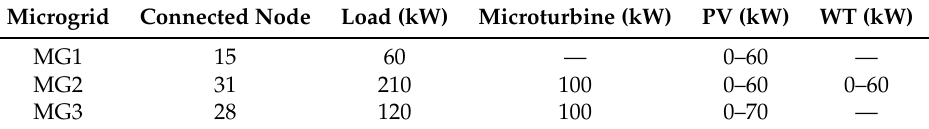
Table 1. Capacity of distributed energy resources (DERs) in each Microgrids (MG).